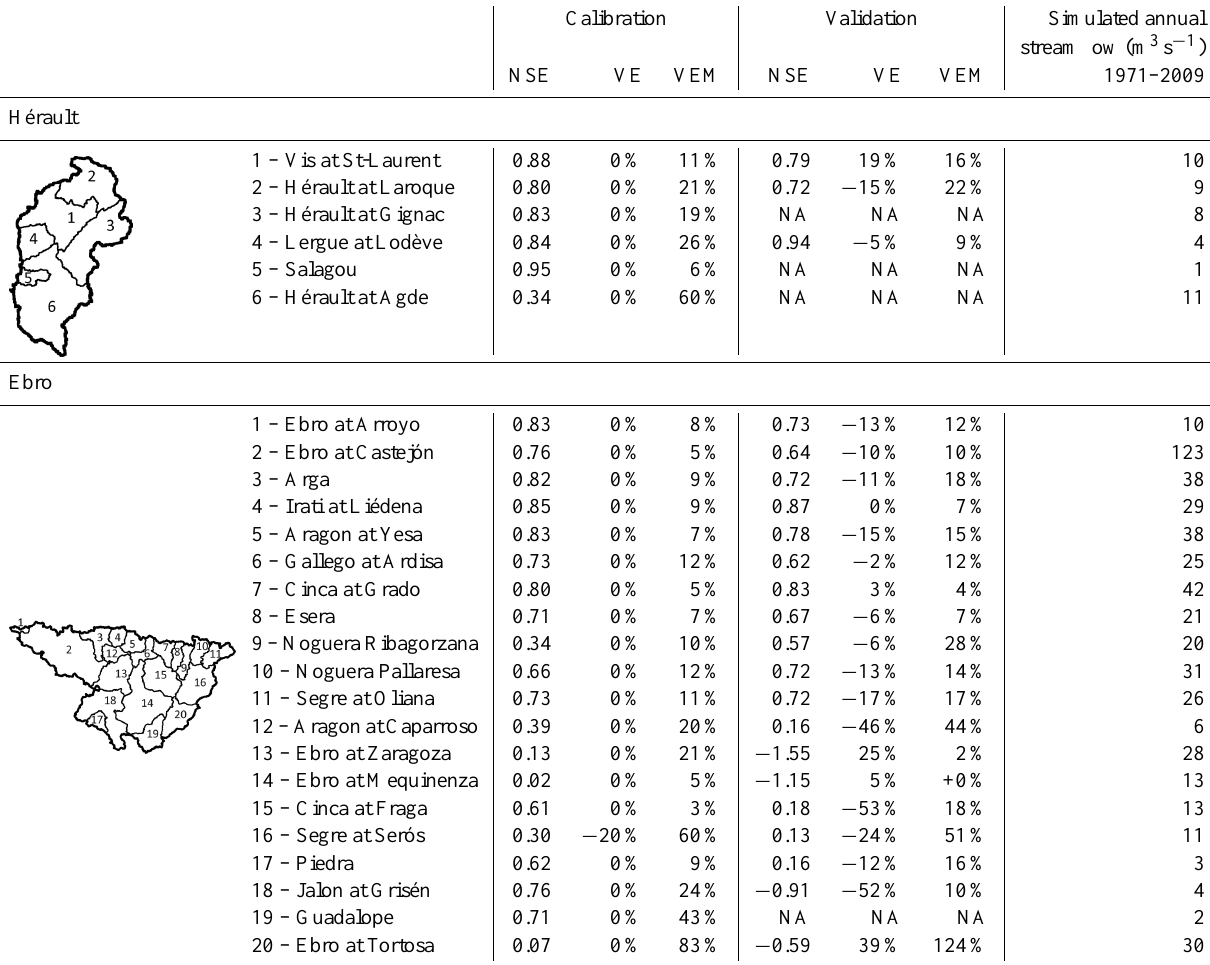
Table 1. Calibration and validation results of the simulation of natural streamflow in the Hérault and the Ebro basins. Optimal values of NSE, VE and VEM are 1, 0 and 0, respectively.